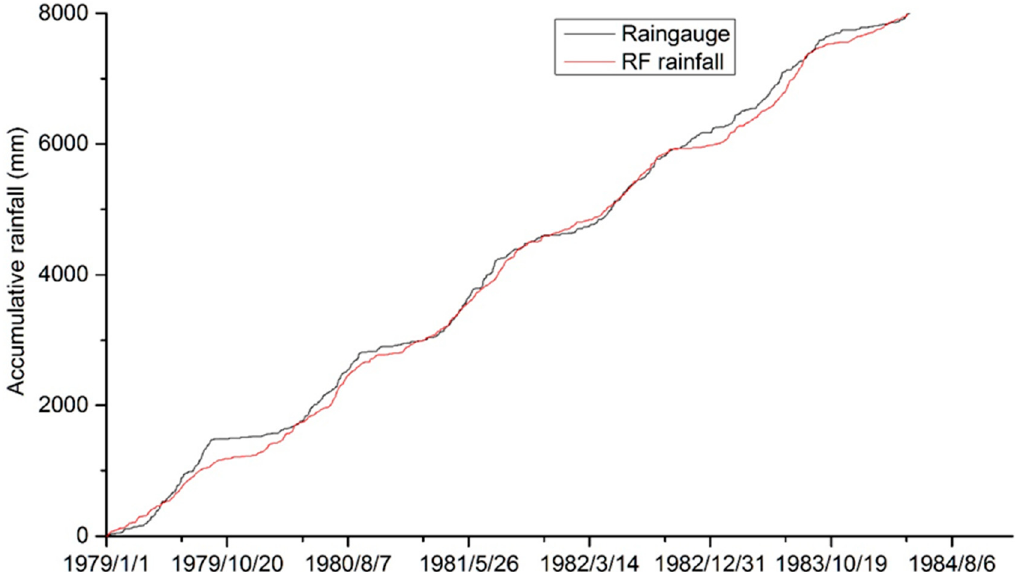
Figure 5. Comparison of cumulative catchment rainfall between historical rainfall from the climate model and rain gauge measurements.